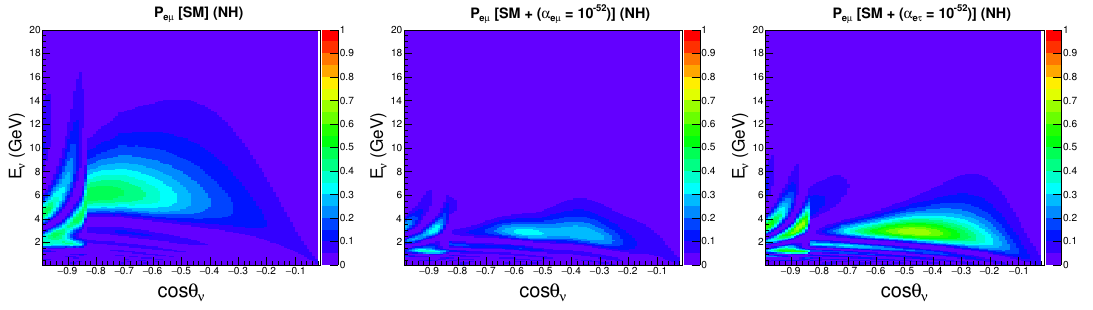
Figure 4 . The oscillograms for (cid:23) e ! (cid:23) (cid:22) channel in E (cid:23) , cos (cid:18) (cid:23) plane for three di(cid:11)erent scenarios: i) (cid:11) e(cid:22) = (cid:11) e(cid:28) = 0 (the SM case, left panel), ii) (cid:11) e(cid:22) = 10 (cid:0) 52 , (cid:11) e(cid:28) = 0 (middle panel), and iii) (cid:11) e(cid:22) = 0, (cid:11) e(cid:28) = 10 (cid:0) 52 (right panel). Here, in all the panels, we assume NH.